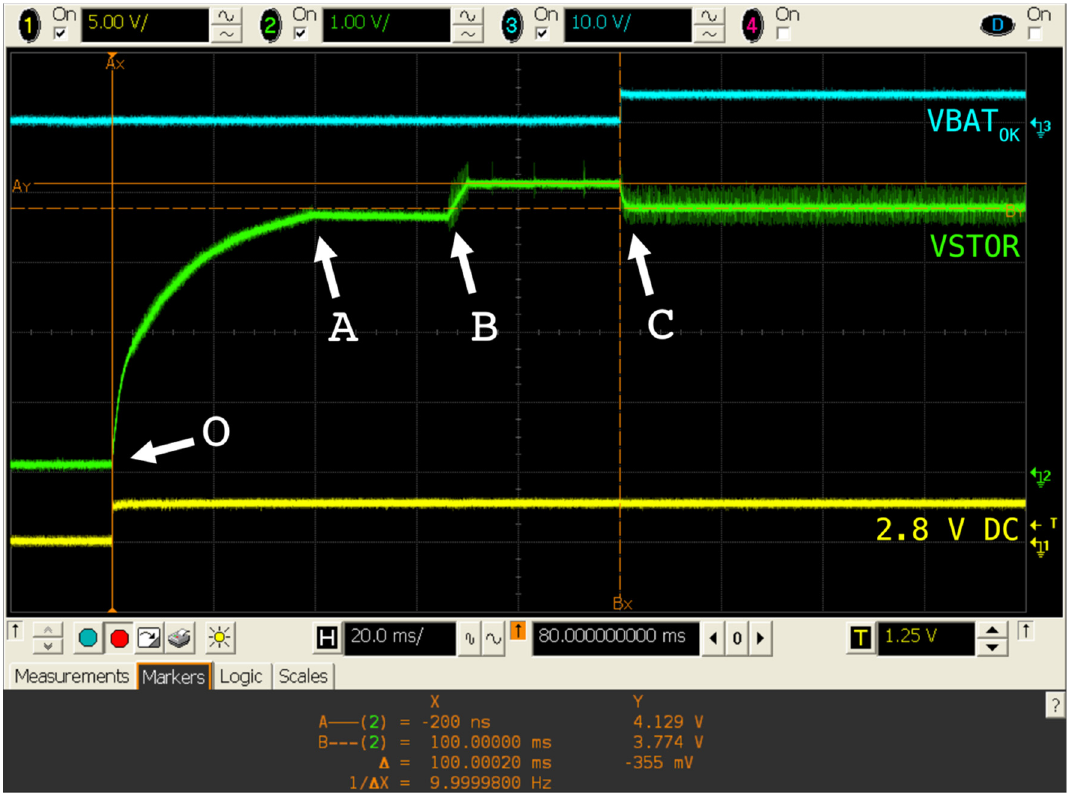
Figure 5. Behavior of BQ25504 when a partially charged battery is attached.